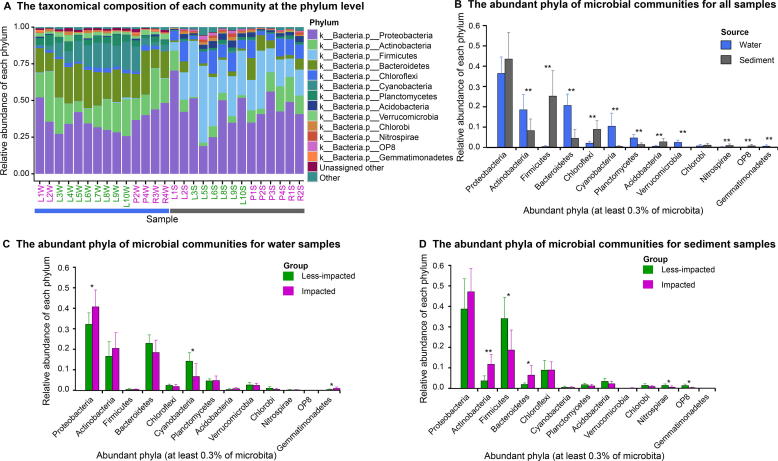
Taxonomic composition and relative abundances of microbial taxa in water and sediment samplesA. Taxonomic composition of each sample at the phylum level. ‘Other’ represents all phyla not included in the top 13 phyla. Samples are named according to the sampling sites (see Figure 1B) with postfixes W and S for water and sediment, respectively. B. Bar plot highlighting differences between water and sediment samples at the phylum level. C. Bar plot highlighting differences in water samples at the phylum level between impacted and less-impacted groups. D. Bar plot highlighting differences in sediment samples at the phylum level between impacted and less-impacted groups. Student’s t-test is performed to determine significant differences between samples collected from different sampling media (water vs. sediment) or locations (impacted and less-impacted). *P < 0.05; **P < 0.01.